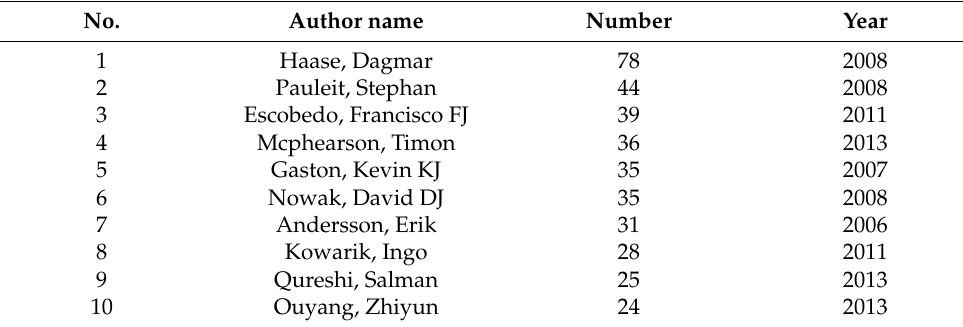
Figure 5. Knowledge map of co-authors of papers published on UES from 1991–2022. Table 3. Top 10 authors by publication volume.